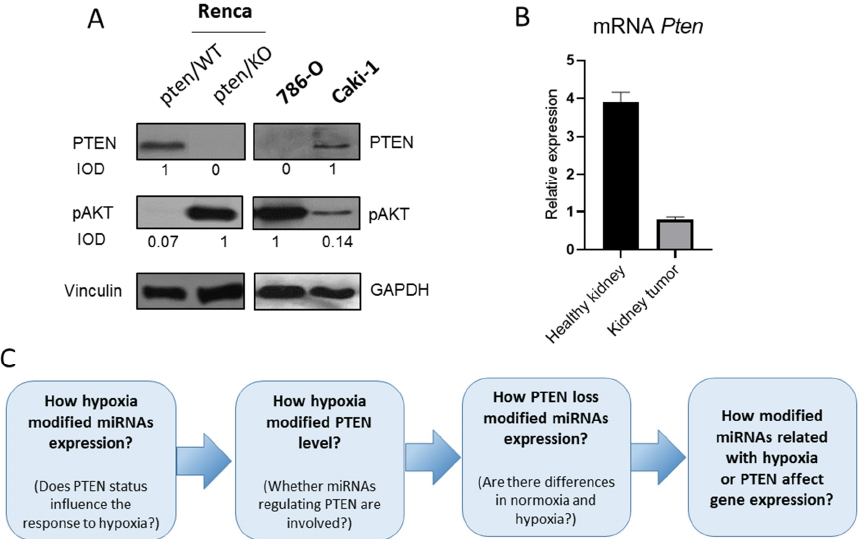
Figure 2. PTEN status in tested models ( A ) PTEN and pAKT levels in kidney cancer cell lines, IOD calculated relative to Vinculin ( B ) Relative to GusB expression of Pten in RNA isolates from kidney cancer and healthy kidney tissues ( C ) graphical workflow.